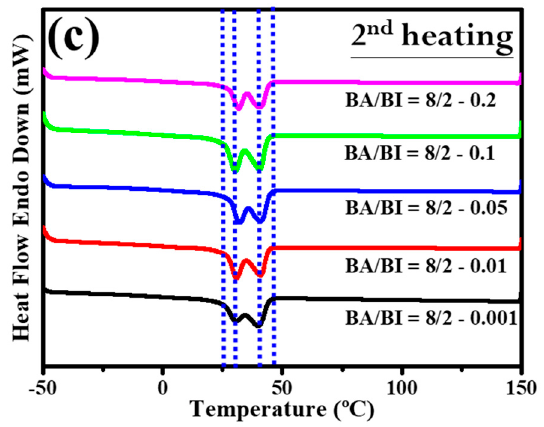
Figure 11. DSC trace of the PBABI copolyesters with different concentrations of EDTA. ( a ) Curves of heating in the first cycle, ( b ) curves of cooling in the first cycle, and ( c ) curves of heating in the second cycle.